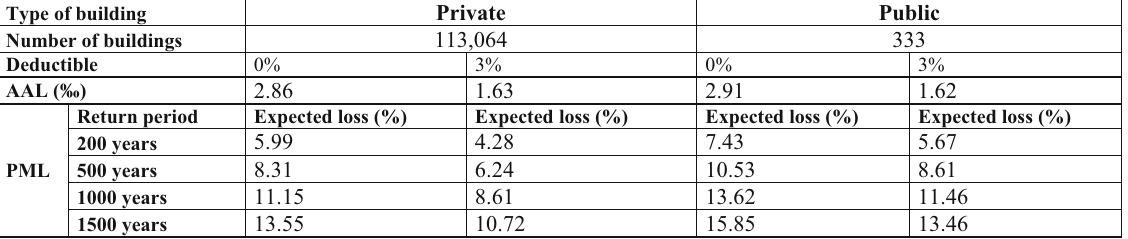
Table 2 Seismic risk results, average annual loss (AAL), and probable maximum loss (PML), for public and private buildings with 0 and 3% deductible levels in Manizales,